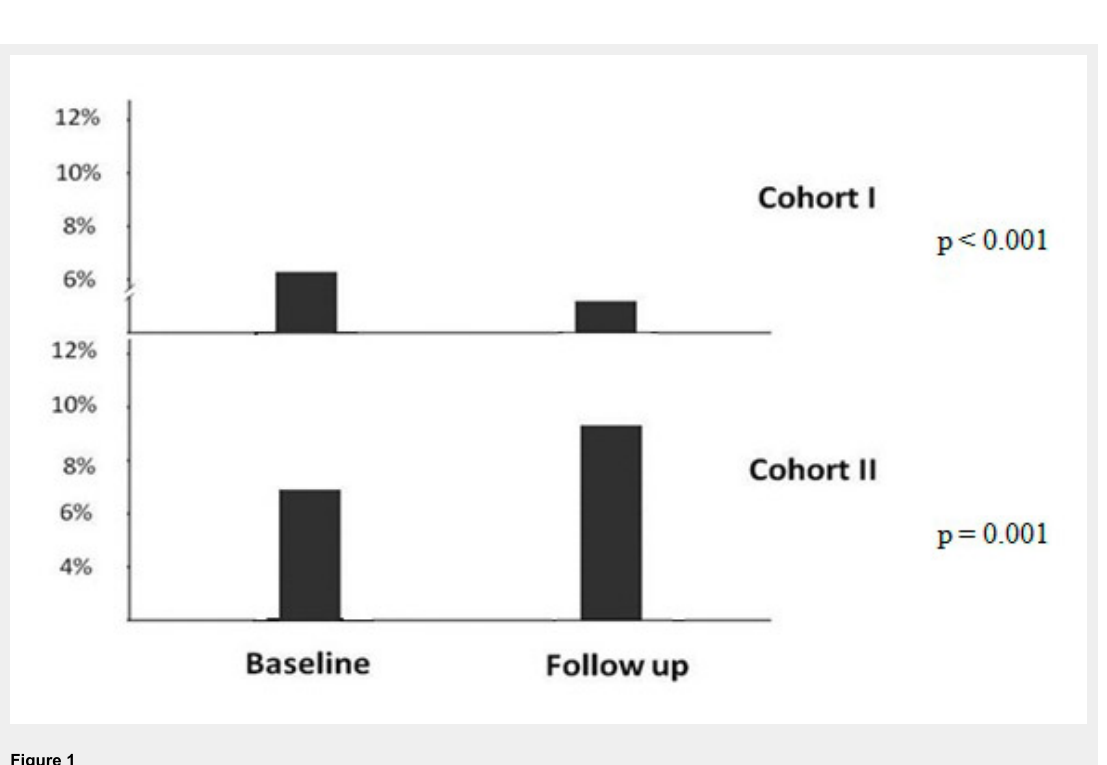
Figure 1 Proportion of patients with LDL cholesterol <70 mg/dl in both